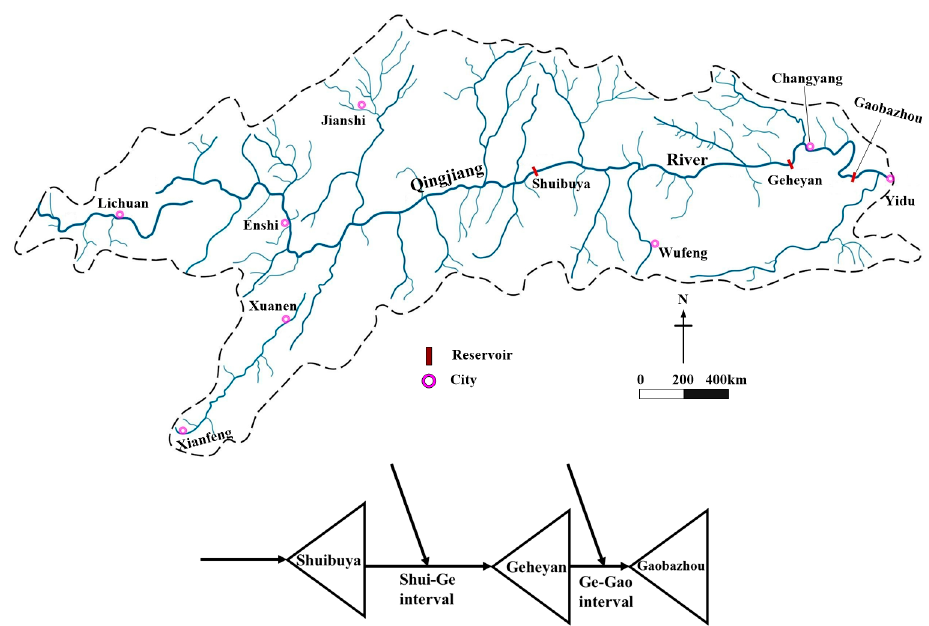
Figure 2. Sketch maps of the Qingjiang cascade reservoirs.